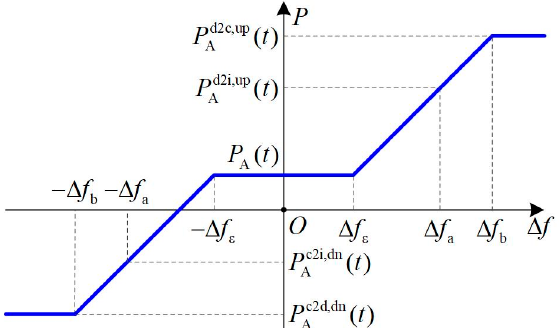
Figure 4. Frequency regulation characteristics of the EV aggregator.